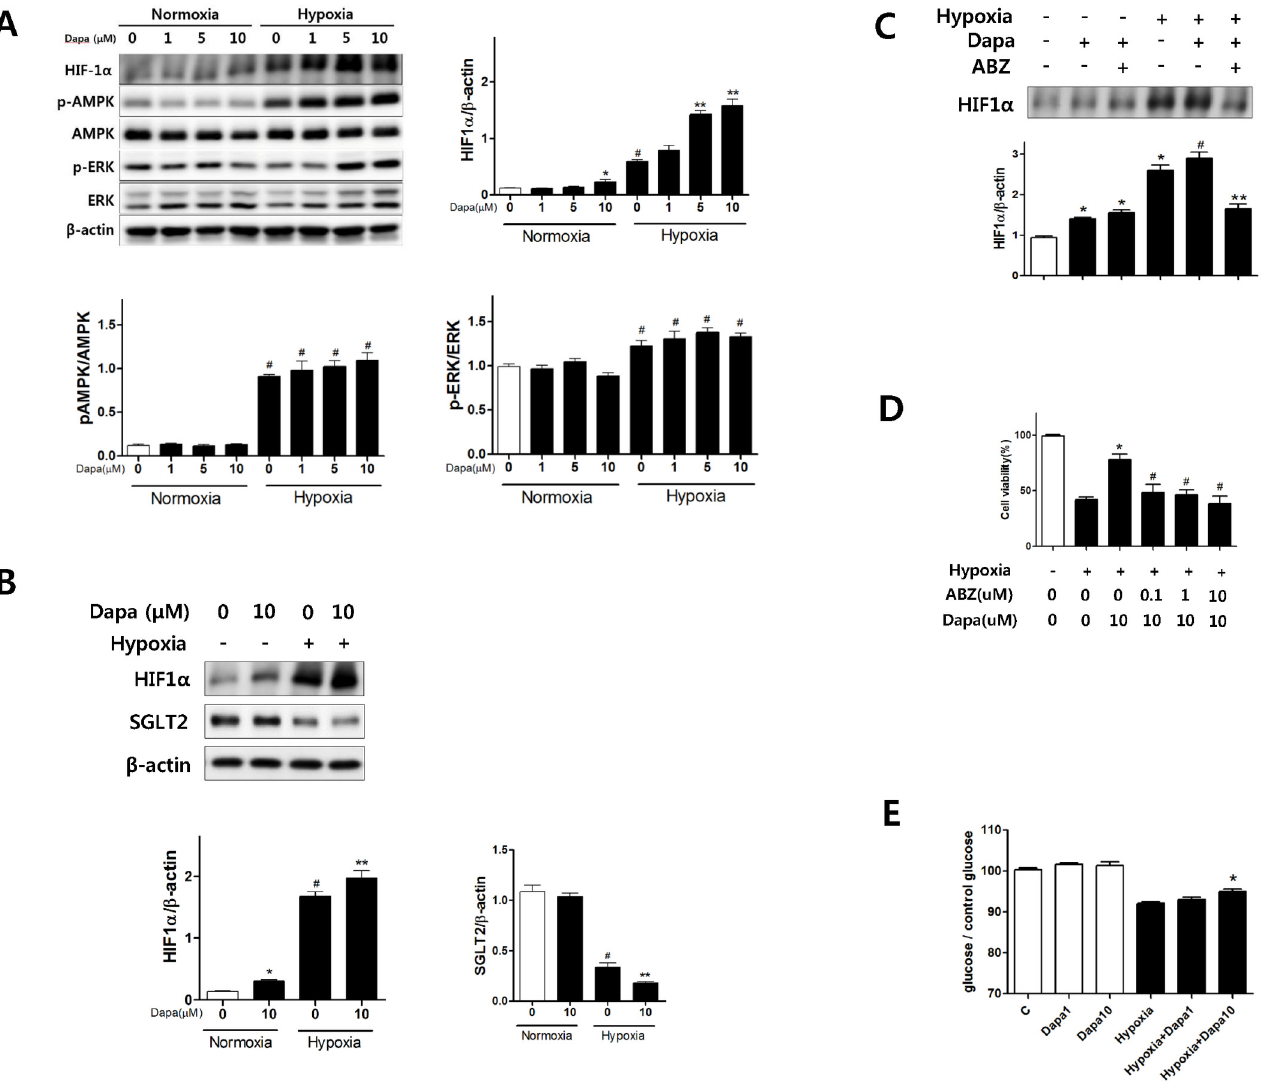
Fig 5. Effects of dapagliflozin on HIF1 in HK2 cells. (A) Representative Western blot: dapagliflozin increased HIF1 expression and phosphorylation of AMPK and ERK in hypoxic HK2 cells. * P < 0.05 vs., dapagliflozin nontreated normoxic HK2 cells, # P < 0.05 vs. normoxic HK2 cells. ** P < 0.05 vs. control hypoxic HK2 cells. (B) Representative Western blot: hypoxia increased HIF1 expression and decreased SGTL2 expression. Dapagliflozin pretreatment decrease SGLT2 expression in hypoxic HK2 cells. * P < 0.05 vs., dapagliflozin nontreated normoxic HK2 cells, # P < 0.05 vs. normoxic HK2 cells. ** P < 0.05 vs. control hypoxic HK2 cells. (C) Dapaglilfozin pretreatment increase HIF1 expression in normoxic and hypoxic HK2 cells compared to control and hypoxic control HK2 cells respectively. Albendazole decreased HIF1 expression in dapagliflozin-treated hypoxic HK2 cells. * P < 0.05 vs., control HK2 cells, # P < 0.05 vs.control hypoxic HK2 cells. ** P < 0.05 vs. albendazole nontreated — dapagliflozin treated hypoxic HK2 cells. (D) Albendazole decreased cell survival in dapagliflozin-treated hypoxic HK2 cells. * P < 0.05 vs., control hypoxic HK2 cells # P < 0.05 vs.dapagliflozin treated hypoxic HK2 cells. (E) Dapagliflozin decreased glucose uptake in hypoxic HK2 cells. * P < 0.05 vs., hypoxic HK2 cells. Bar represents mean ± s.d. All cellular experiment repeated three times for western blot, cell viability test, and glucose uptake test. doi:10.1371/journal.pone.0158810.g005 PLOS ONE | DOI:10.1371/journal.pone.0158810 July 8,